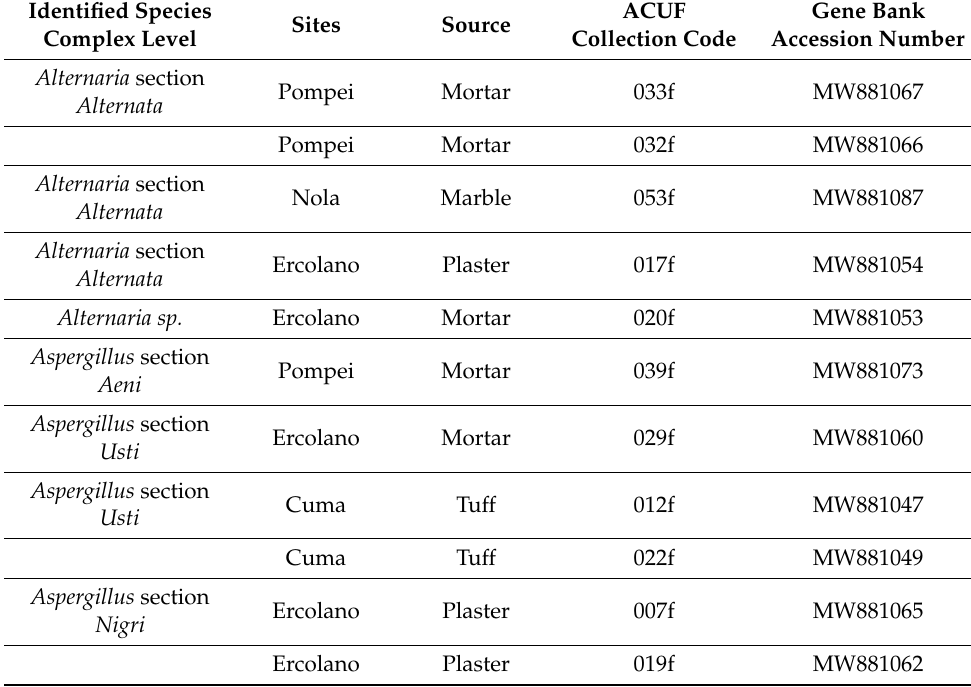
Table 2. Identification of the fungal species complex level based on ITS sequences with the description of their sampling site and lithic substrate. ACUF Collection Codes and Gene Bank Accession numbers are given for each